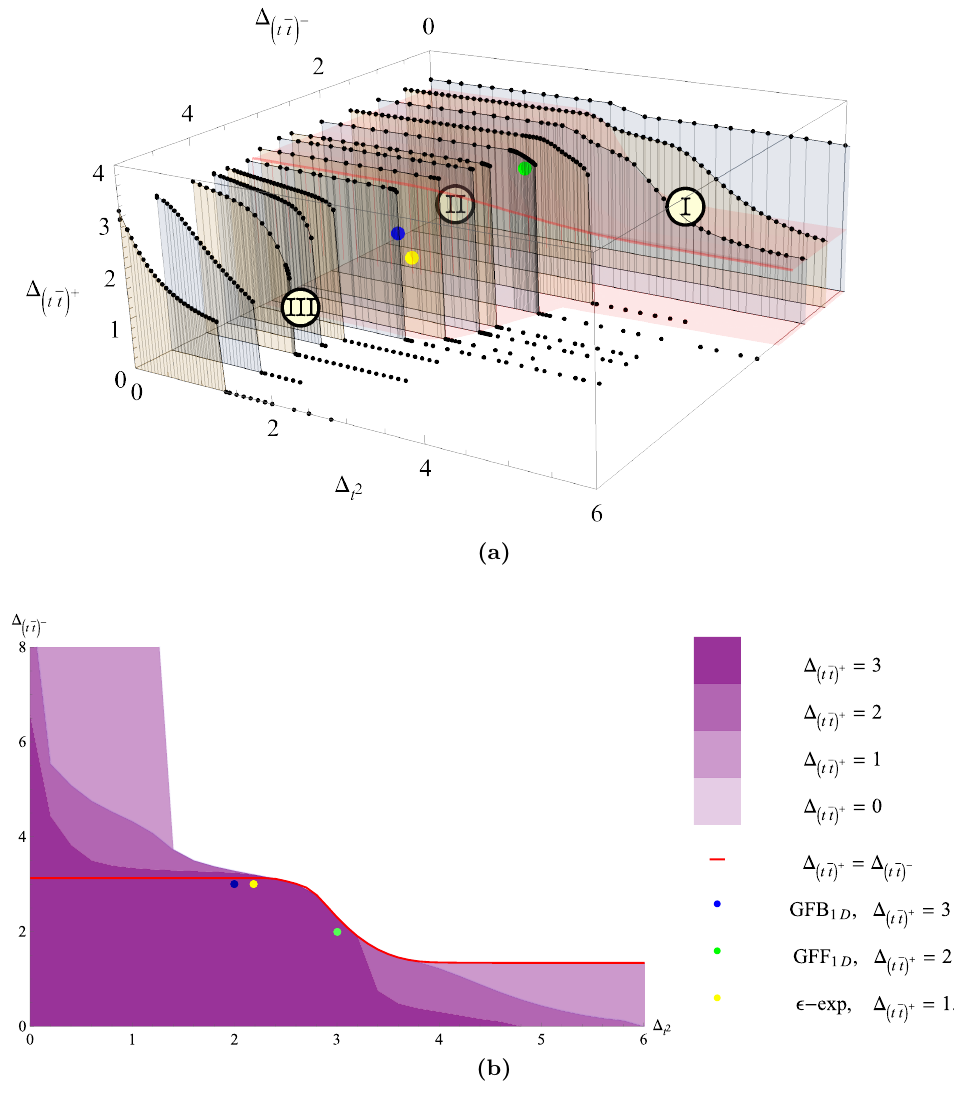
Figure 3. Bounds on the maximal gap on the dimension of the S -parity even scalar ( t ¯ t ) + (a) or S -parity odd scalar ( t ¯ t ) − (b) vs. the S -parity odd (a) or even (b) scalar gap vs. the gap on the leading charged operator t 2 . Λ = 33 , P = 53 . The green and blue dots correspond to the solutions for GFF and GFB, respectively. The yellow dot is the 1-loop ε -expansion prediction for the magnetic line defect discussed in section 3.2. The solid red line in (b) is the ‘agnostic’ bound for ∆ = ∆ ( t ¯ t ) + ( t ¯ t ) −